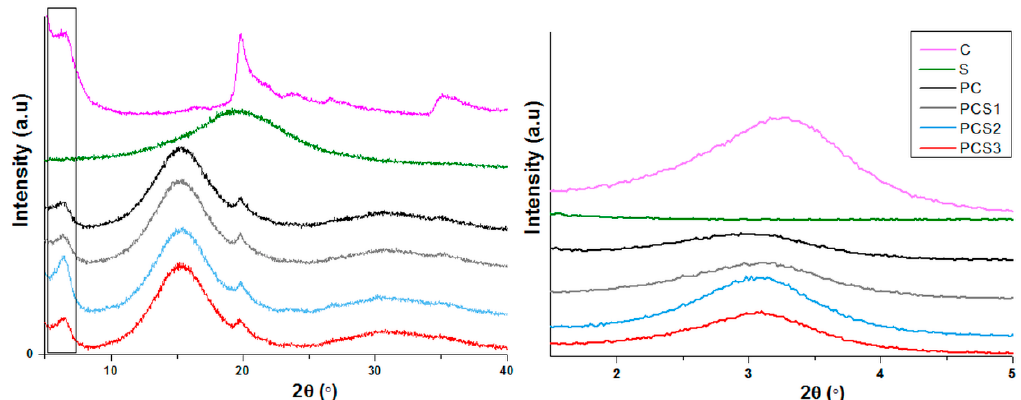
Figure 4. XRD patterns (wide angle—I and low angle—II) for clay, Salecan and synthesized nancomposite samples.